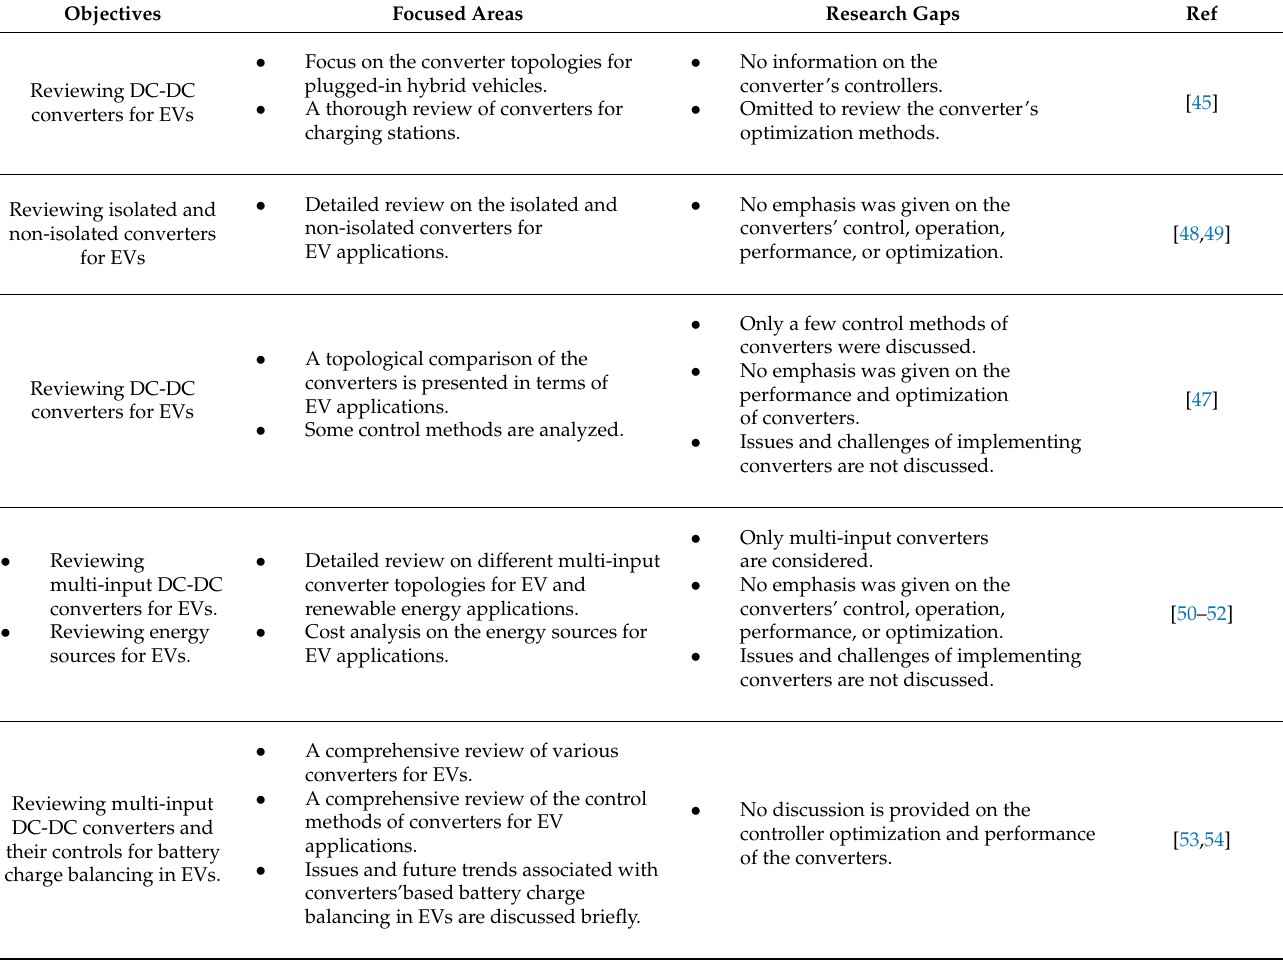
Table 1. The notable studies on EV power electronics converters, focused areas, and research